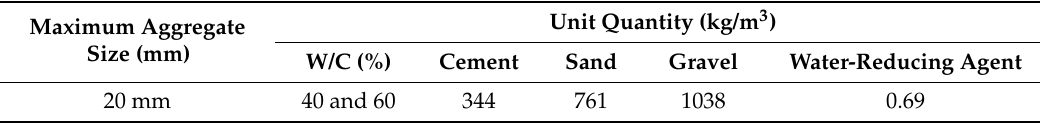
Table 1. Design mix of